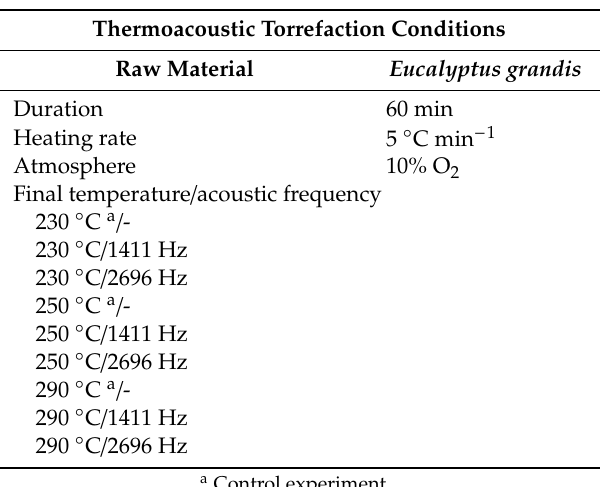
Table 2. Thermo-acoustic torrefaction